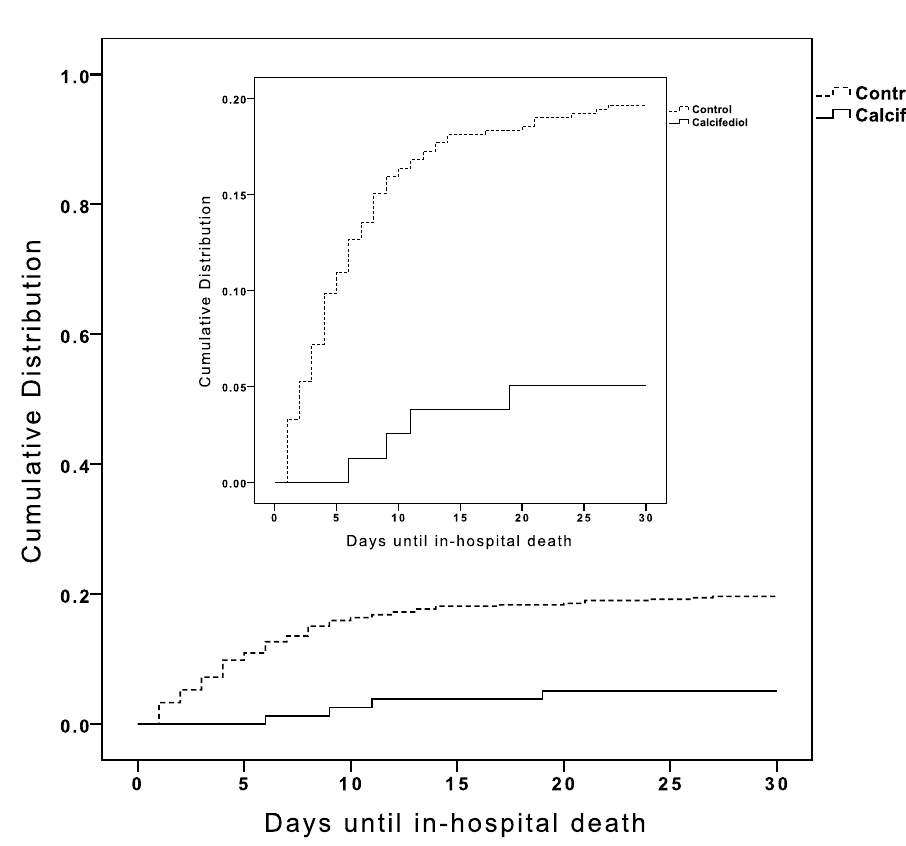
Figure 2. Cumulative distribution of patients presenting in-hospital death according to treatment groups.